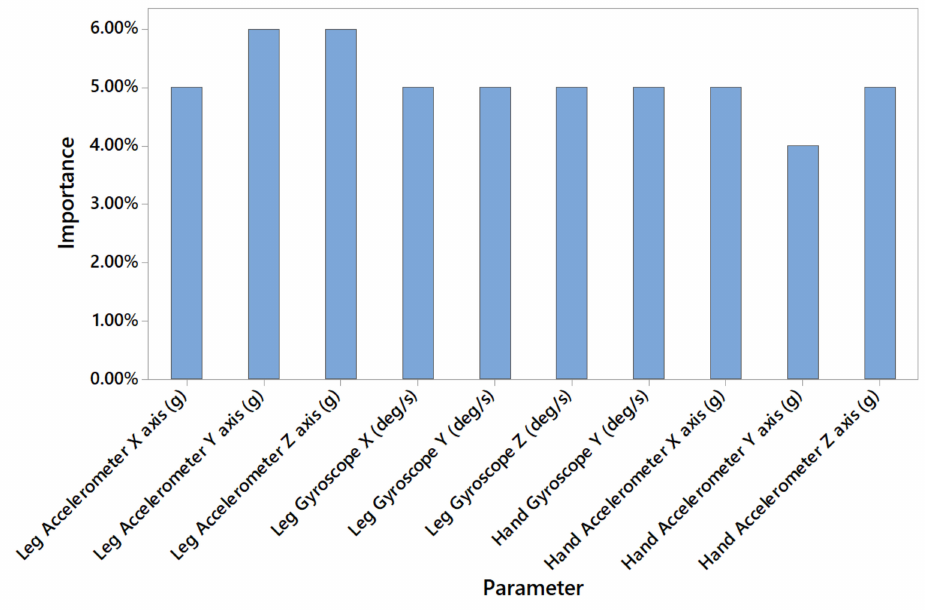
Figure 8. Predictors importance for model 11 trained with dataset A (19 July 2019 interval).